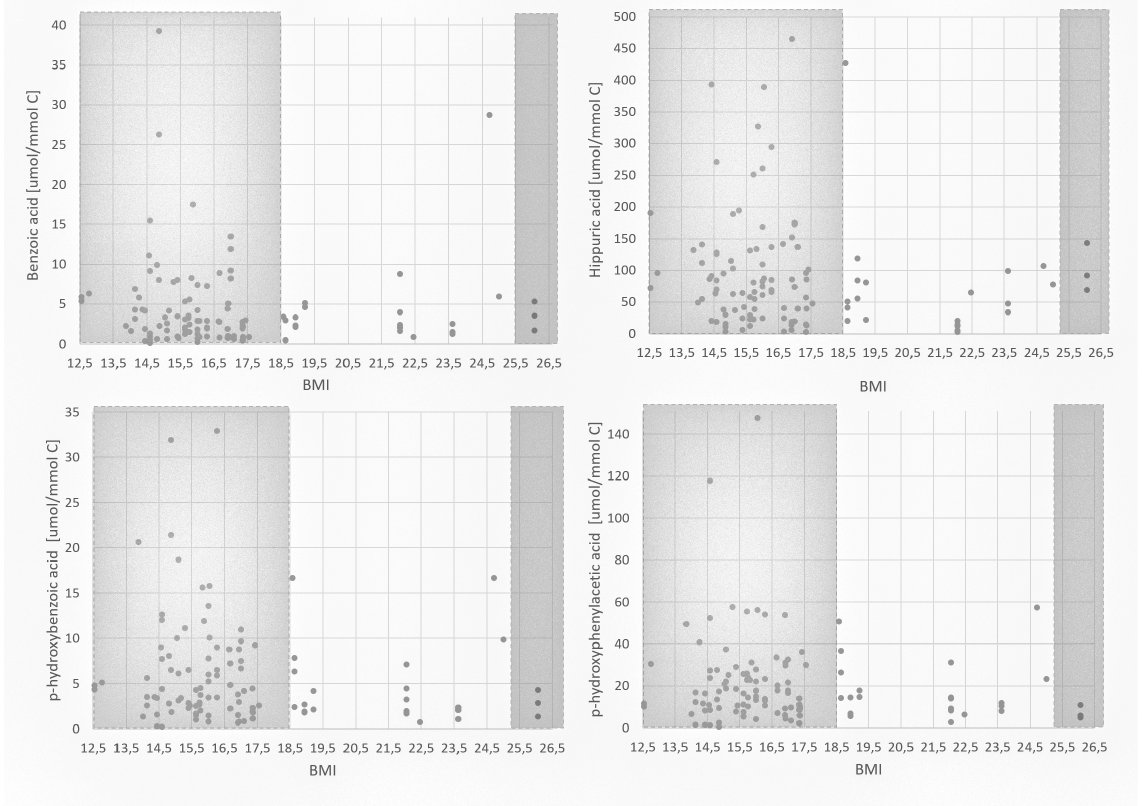
of patients does not seem to influence the concentrations of the other acids (hippuric acid: p=0.22; p -hydroxybenzoic